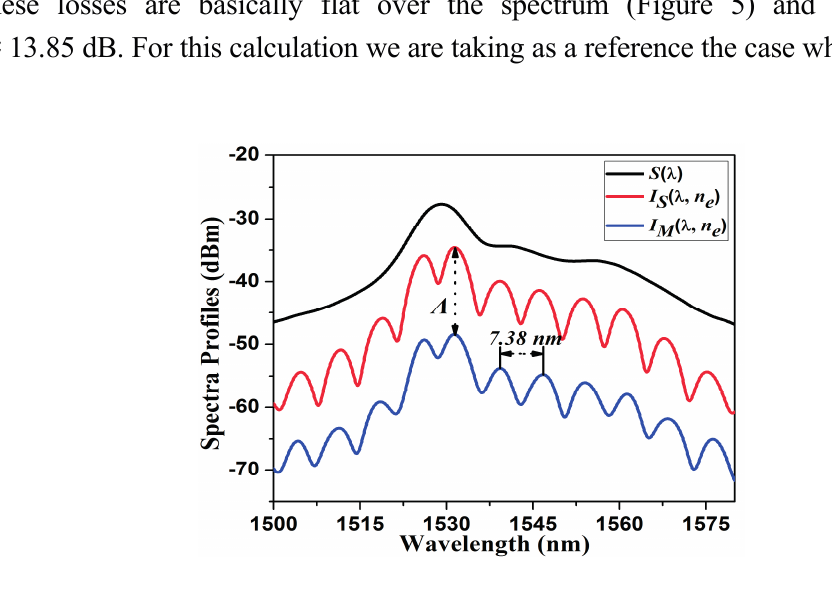
Figure 5. Measured source spectral profile and the simulated FPI reflection spectrum respectively. For this case 1